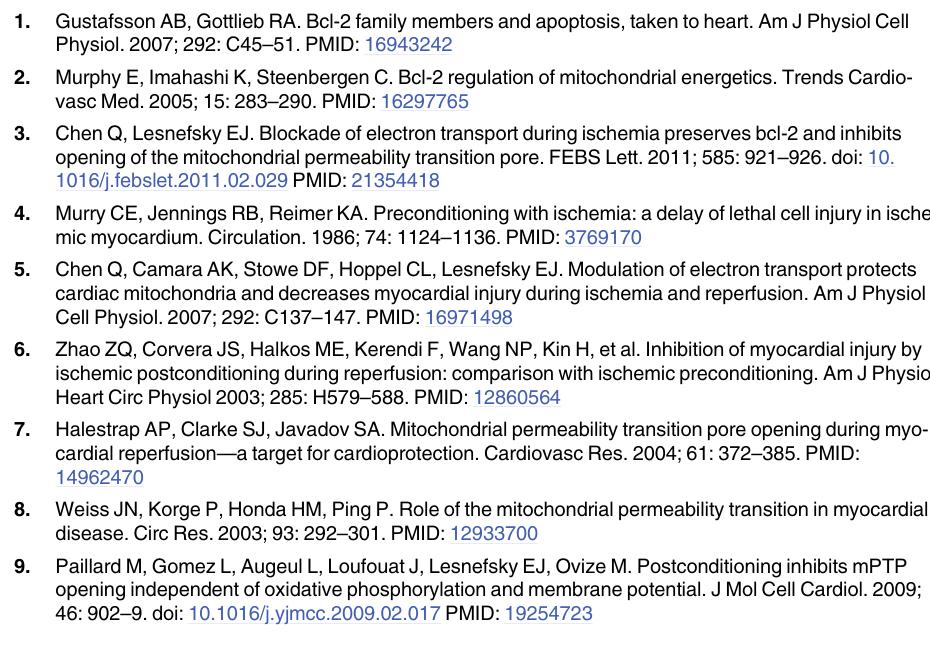
decreased the CRC compared to ischemia, indicating that reperfusion further sensitizes the